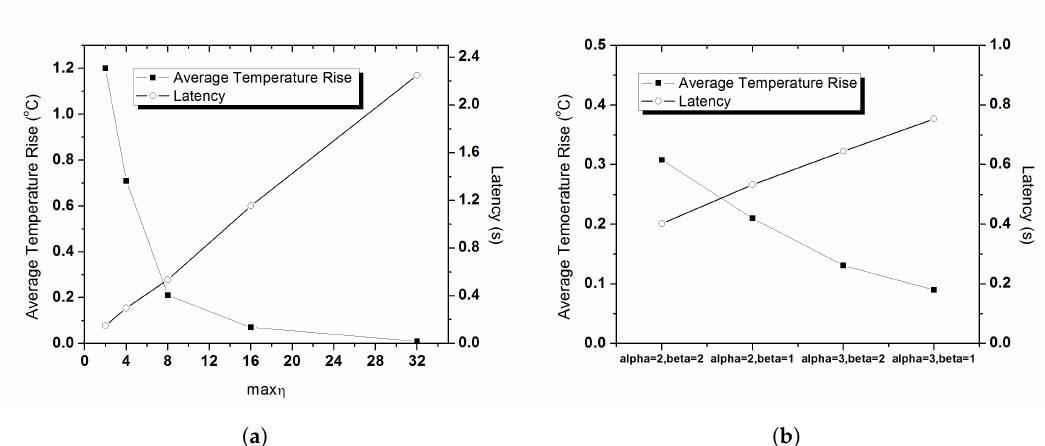
Figure 13. Impact of constant parameters. ( a ) Impact of max η on thermal rise and latency. ( b ) Impact of α , β on thermal rise and